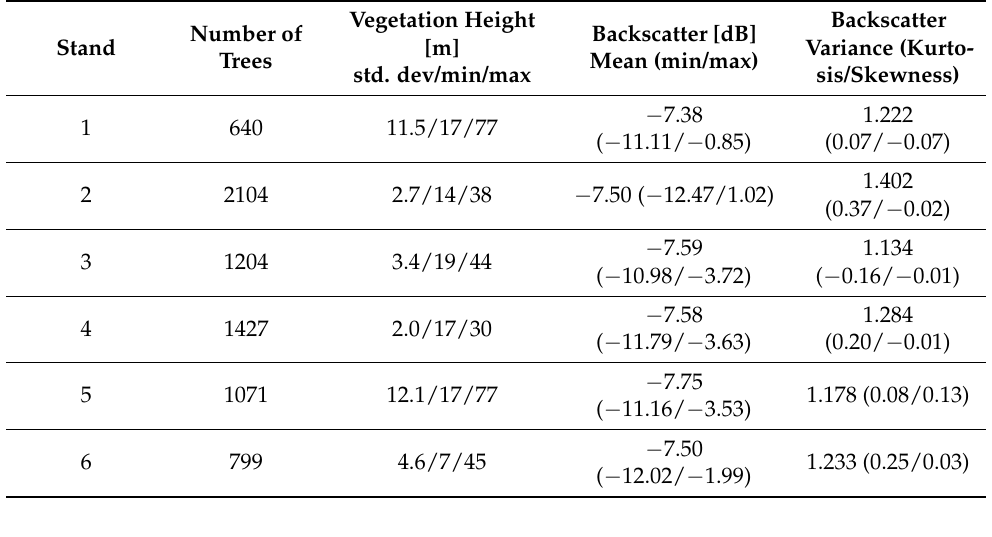
Table 2. Backscatter summary statistics.